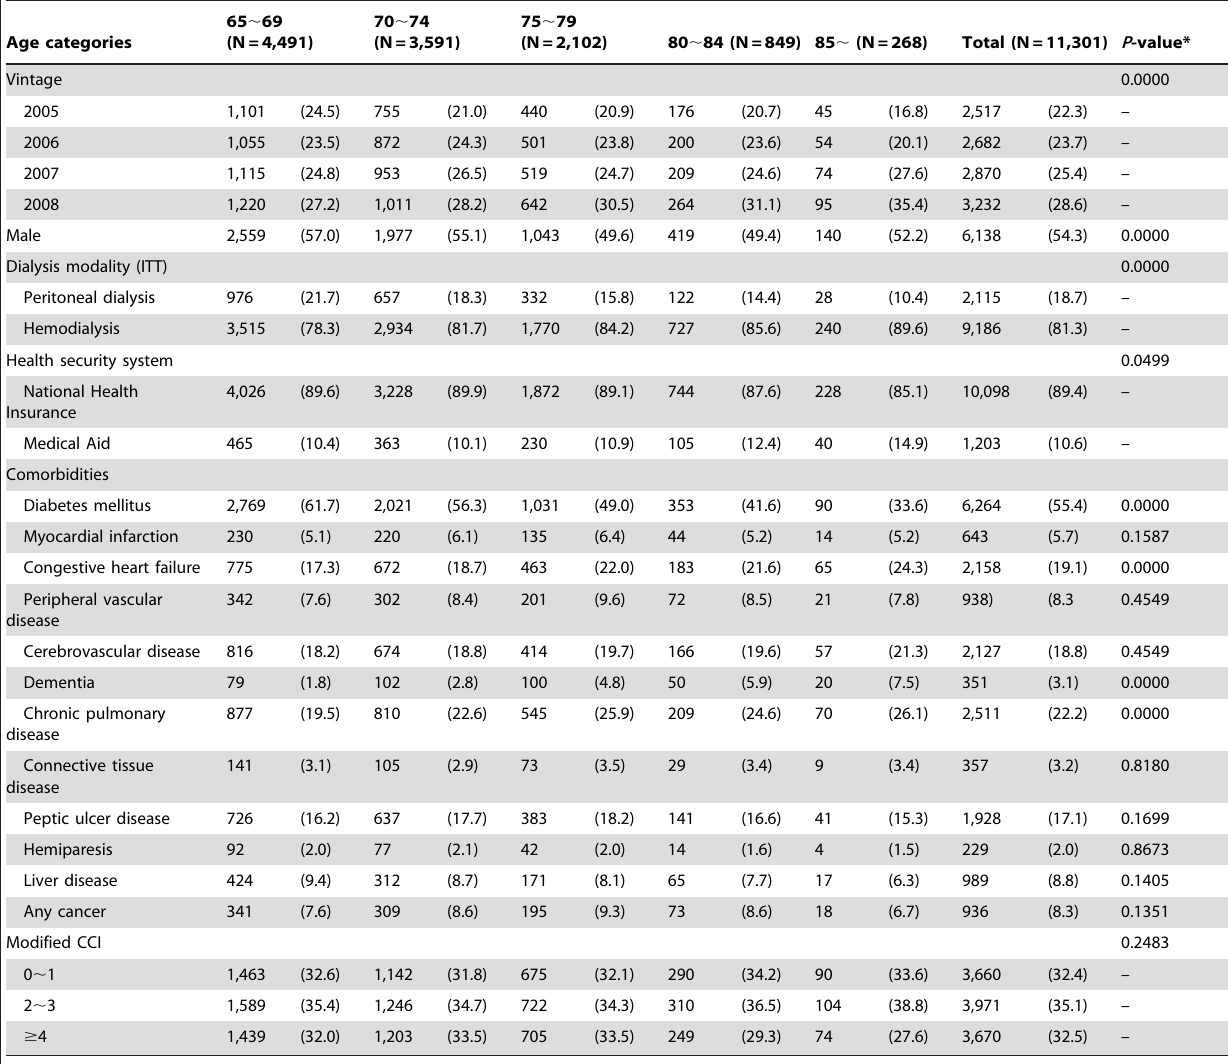
Table 1. Baseline